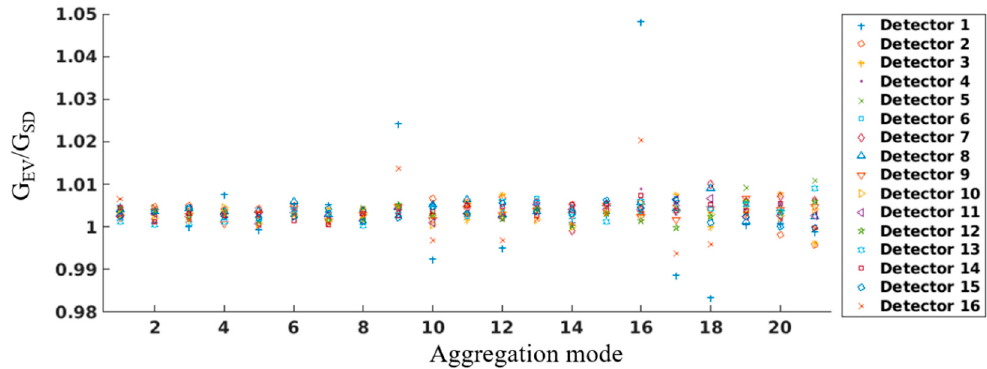
Figure 5. Ratio between the prelaunch LGS EV and SD gain. Data for HAM side A are shown.